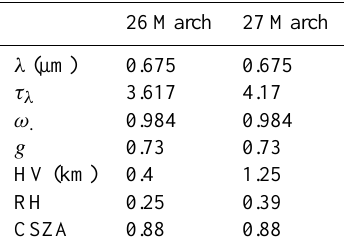
Table 3. The critical input parameters of the SBDART